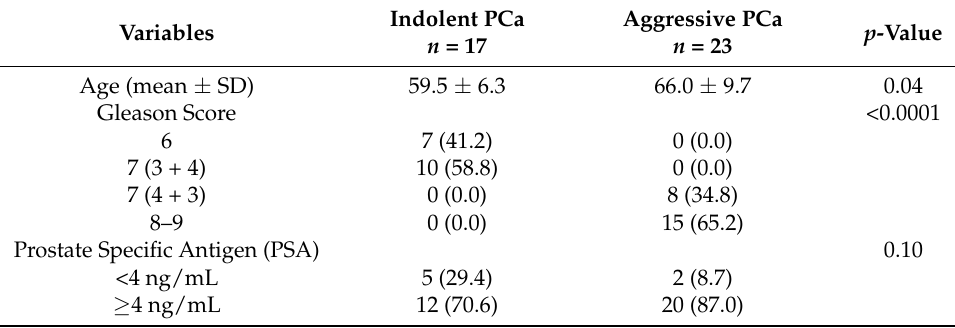
Table 2. Clinicopathological variables for the study group of men with prostate cancer.